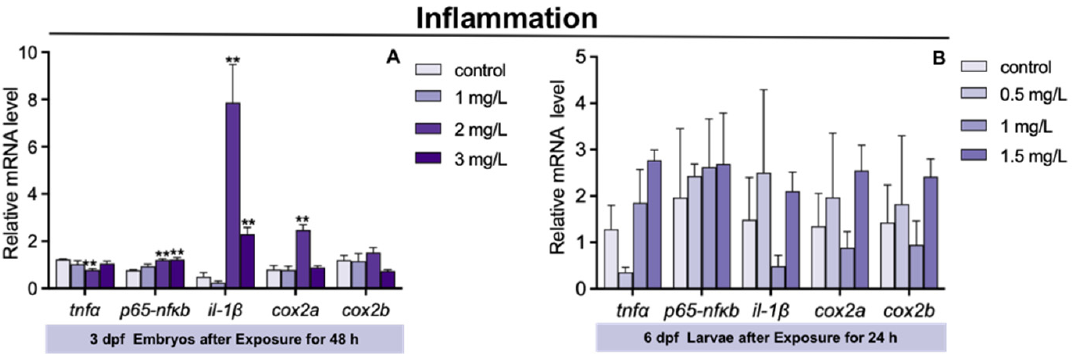
Figure 5. The expression of inflammatory genes (including tnf α , il-1 β , p65-nf κ b , cox2a , and cox2b ) in zebrafish. ( A ) For 3 dpf zebrafish embryos, the expression of tnf α , il-1 β , p65-nf κ b , cox2a , and cox2b after triflumizole exposure for 48 h. ( B ) For 6 dpf zebrafish larvae, the expression of tnf α , il-1 β , p65-nf κ b , cox2a , and cox2b after triflumizole exposure for 24 h. Data are expressed as the mean of three replicates ± standard error (SEM). Asterisks denote significant differences between the control group and TFZ groups (determined by Dunnett post hoc comparison, ** p < 0.01). tnf α : tumor necrosis factor α ; il-1 β : interleukin 1, beta; p65-nf κ b : p65-nuclear transcription factor κ B; cox2a : cyclooxygenase type 2 a; cox2b : cyclooxygenase type 2 b. Compared to the control group, the expression of tnf α , p65-nf κ b , il-1 β , cox2a , and cox2b in 6 dpf zebrafish larvae was of no significance in the 0.5, 1, and 1.5 mg/L TFZ groups ( p > 0.05, Figure 5B).